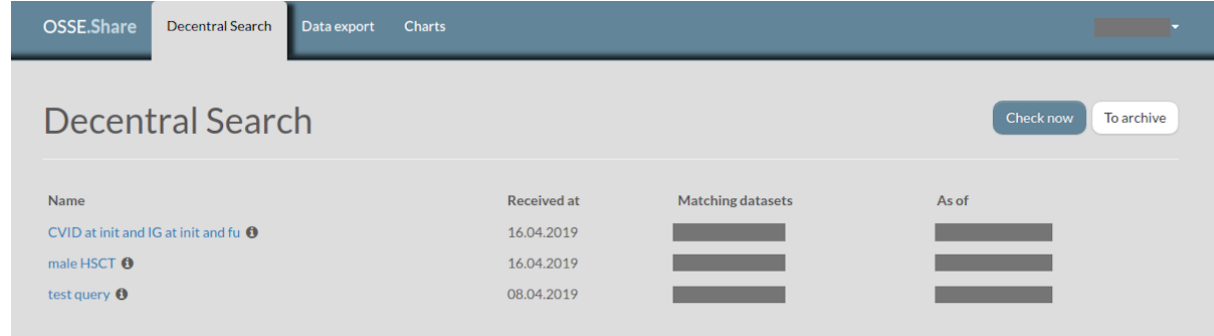
Figure 5. The local collaboration client, which is part of the OSSE bridgehead installation, lists all incoming inquiries. Further, one sees the date of last execution (As of) as well as the number of matching patients (Matching datasets). CVID: common variable immunodeficiency; fu: follow-up; HSCT: hematopoietic stem cell transplantation; IG: immunoglobulin; init: initial registration; OSSE: Open Source Registry System for Rare Diseases ( Open-Source-Registersystem für Seltene Erkrankungen , in